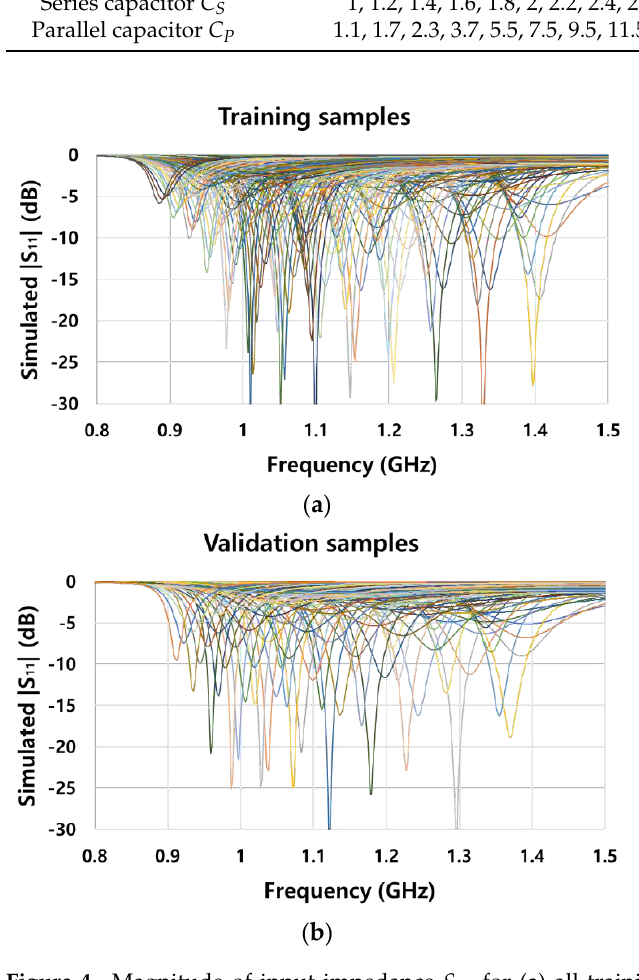
Table 2. Capacitor values in matching circuit for validation.